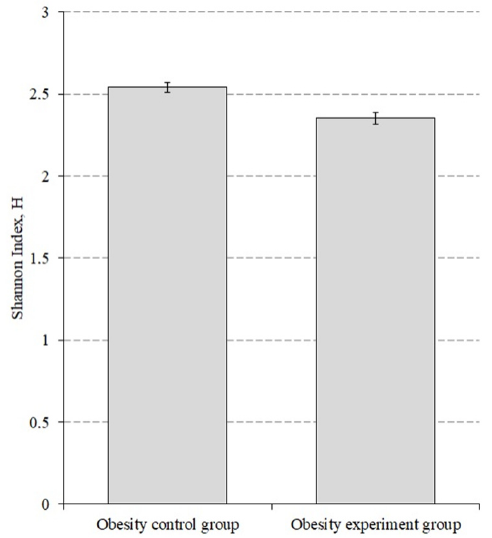
Figure 4. The alpha diversity index for the obesity patients before and after the intake of lactic acid bacteria. p < 0.001.